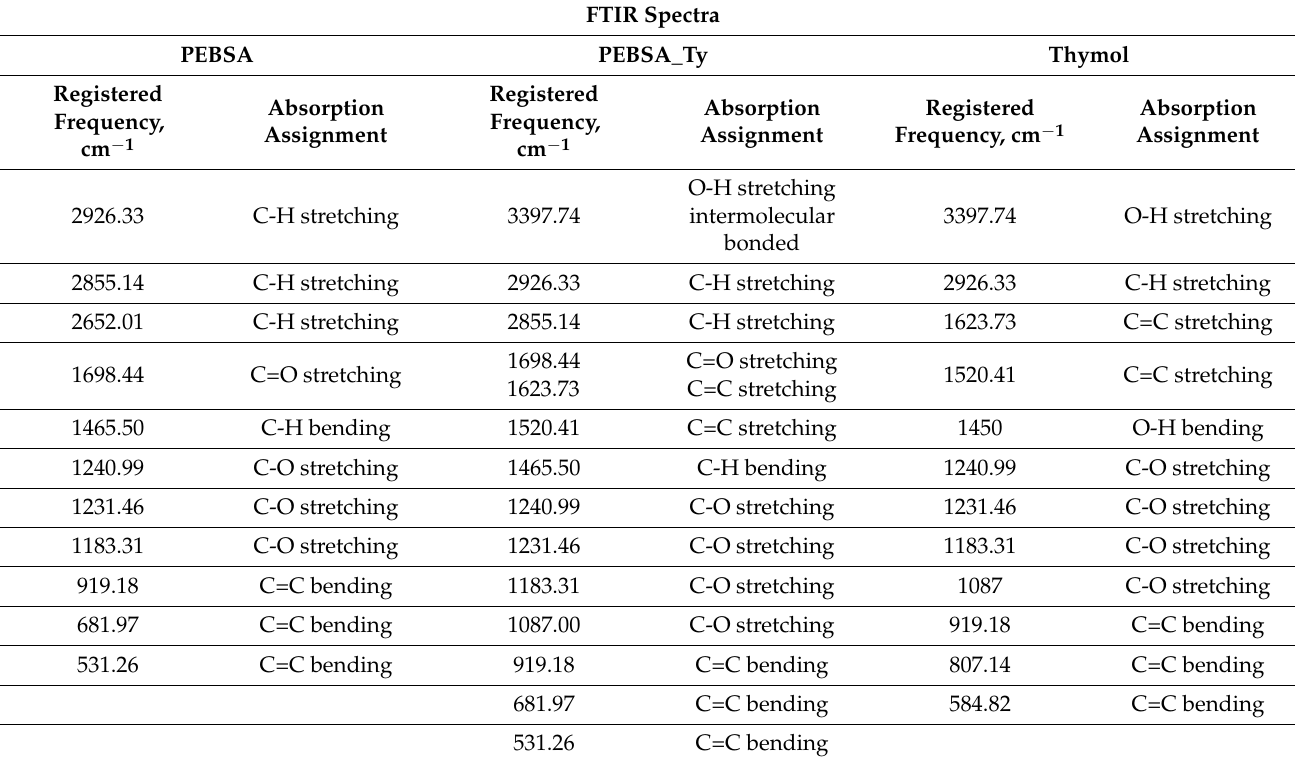
Table 1. The registered frequencies in the PEBSA, PEBSA_Ty, and thymol FTIR spectra and their absorption assignments. FTIR